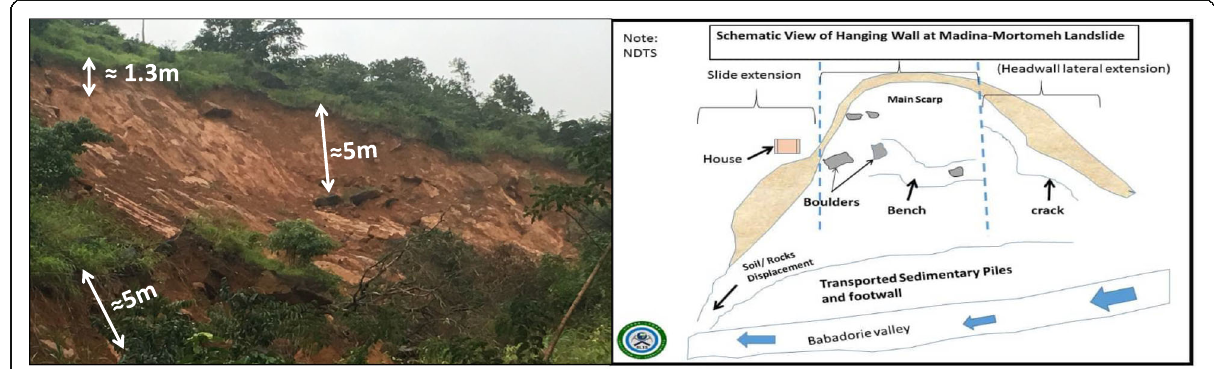
Fig. 7 Madina Landslide ( a ) lateral movement of the headwall along pre-slide shallow lineament, which disappear on the scar surface; ( b ) well- labeled sketch of the plan